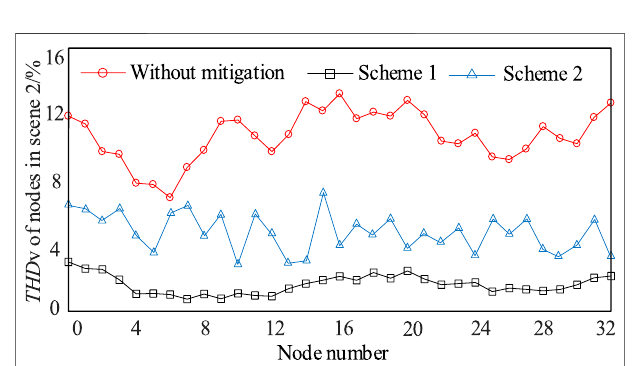
FIGURE 3 | Total voltage distortion rate of each node before and after mitigation under scenario 2.